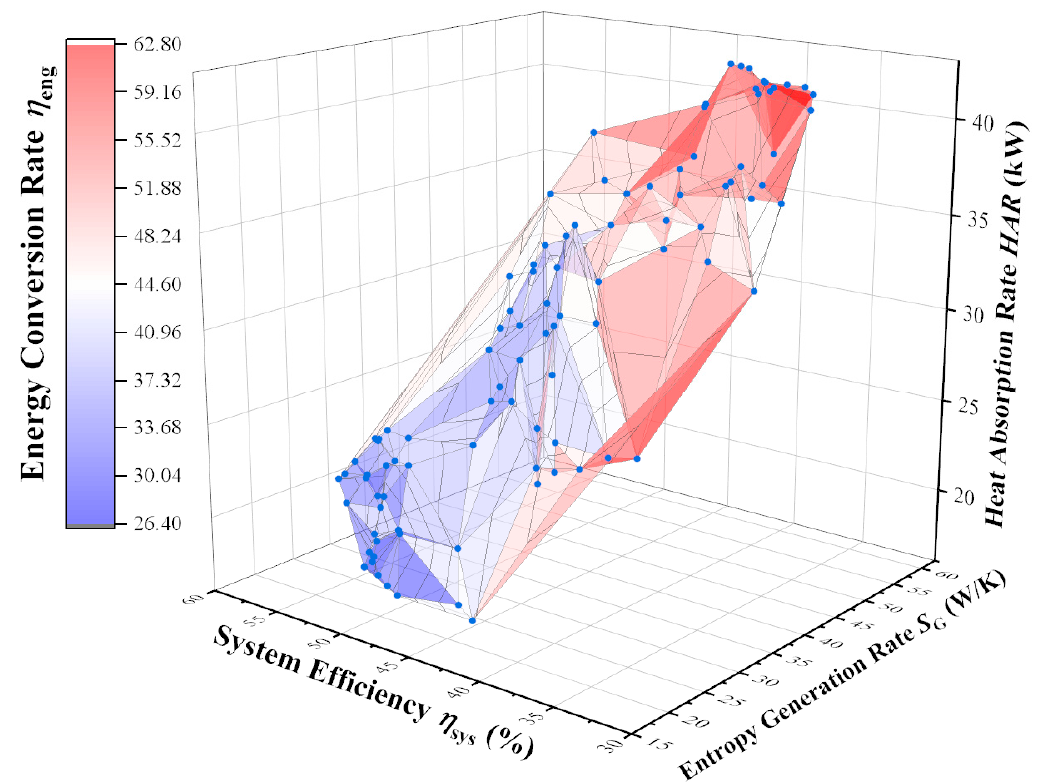
Figure 6. Pareto Front of four-objective optimization at 800 W/m 2 . Table 4. Feature point parameters on the Pareto Front of four-objective optimization at 800 W/m 2.